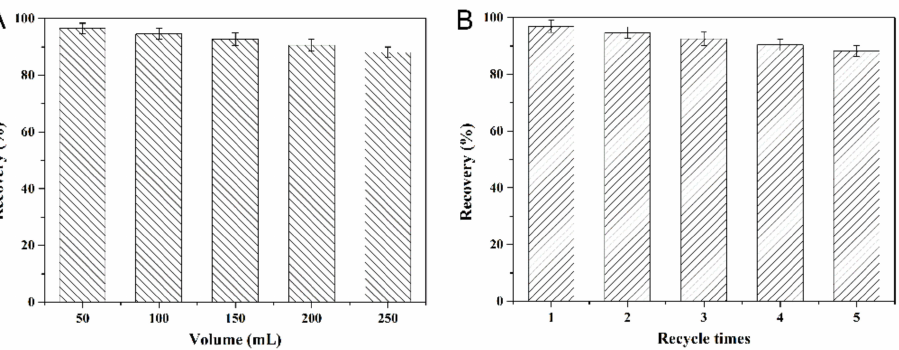
Figure 4. ( A ) Recovery rates of BPA in different sample volumes; ( B ) reusability of the Fe 3 O 4 @ZIF-